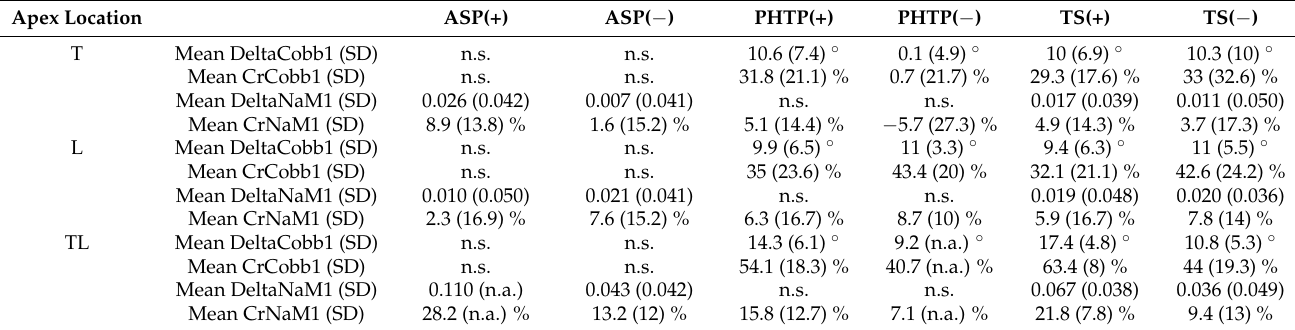
Table 4. Apex-specific brace parameter effects on (major) curve.